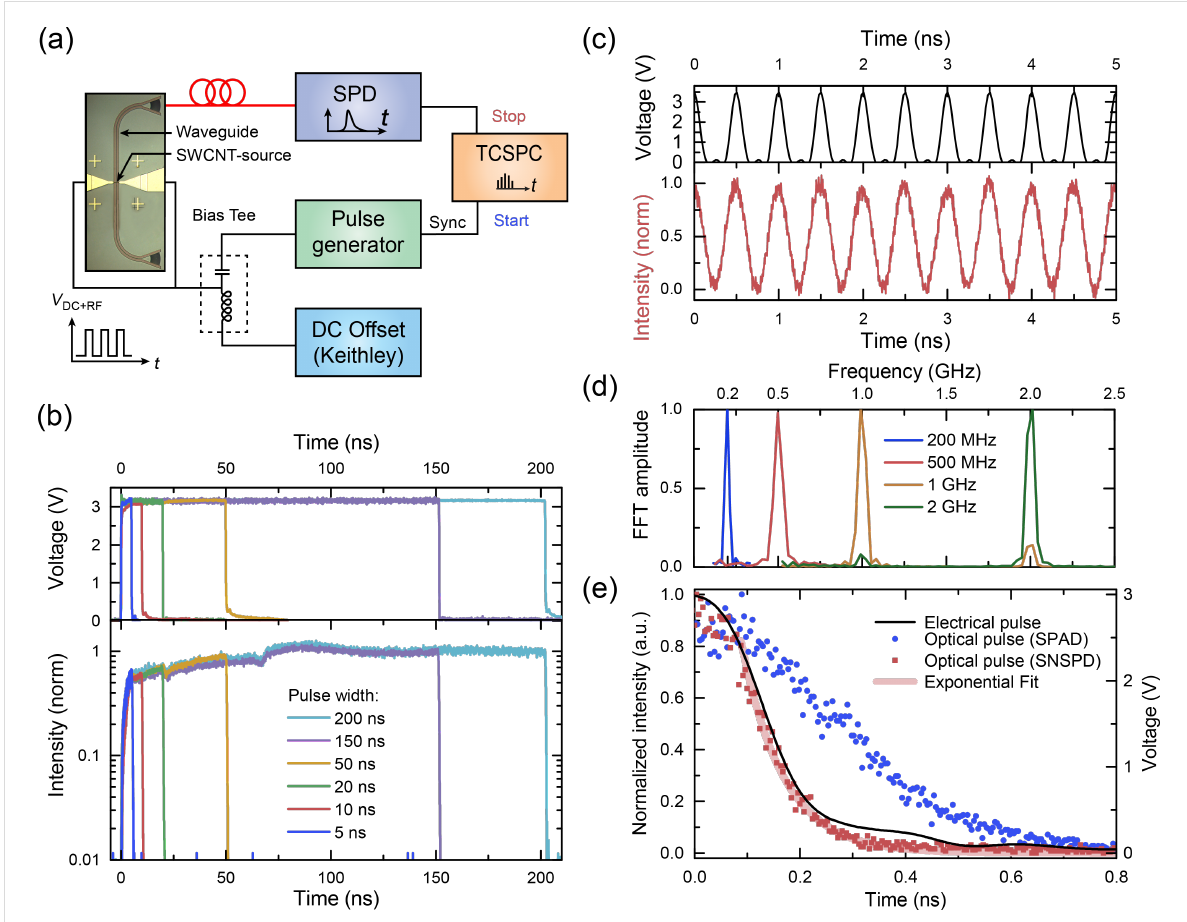
Figure 4: (a) WG-CNT transducer characterized by the fiber-coupled setup. (b) Comparison of electrical pulses with TCSPC-histograms of optical pulses, measured at a grating coupler. (c) Sequence of electrical pulses (150 ps width, 2 GHz, 10 V DC and 3.3 V pulse ) as well as emission pulses. (d) Normalized fast Fourier transform (FFT) spectra of modulated CNTs, emitting at frequencies of 0.2, 0.5, 1 and 2 GHz. (e) The decay of the CNT- emission following the trailing edge of an electrical pulse (black line) was measured with the slow SPAD (blue symbols) and fast SNSPD (red symbols) along with fitted exponential decay curve (decay time τ = 79 ps). The broadening of the electrical signal along with a small bump at 0.4 ns occurs because of impedance